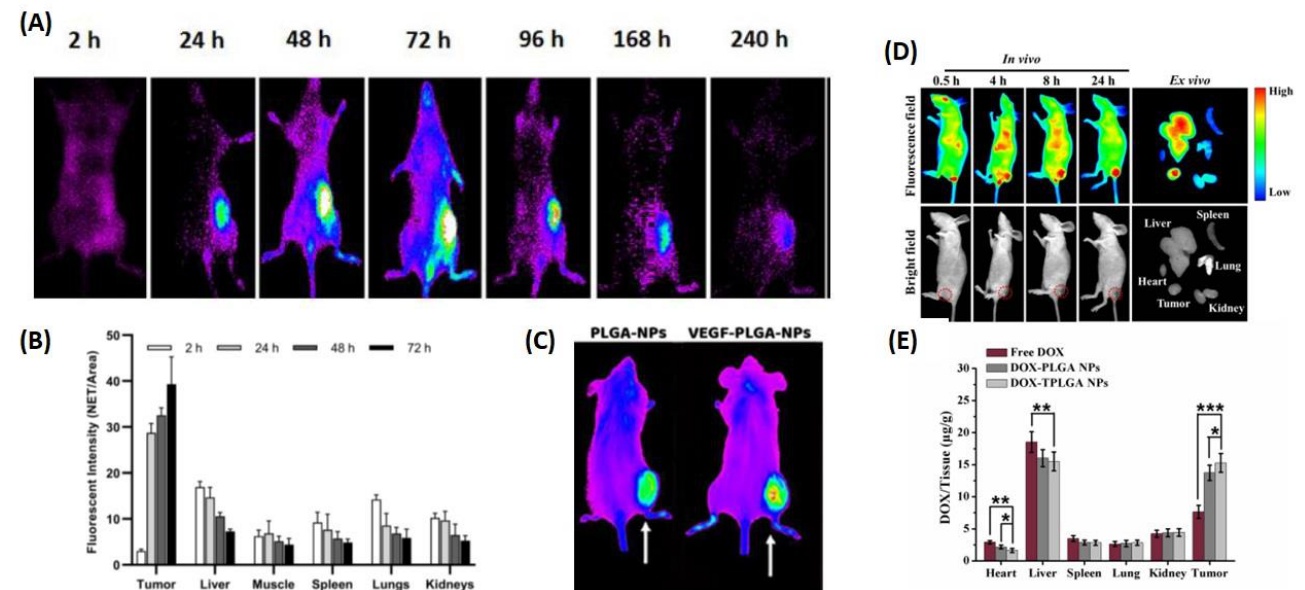
Figure 8. The figure represents different applications of PLGA. ( A ) Optical photographs taken of the entire mouse after 2, 24, 48, 72, 96, 168, and 240 h after subcutaneous injection of 500 µg of fluorescent PLGA-NPs in the right flank in a syngeneic tumor-bearing mouse. ( B ) Analyzing the PLGA-NPs’ biodistribution in BALB/c mice. This data is shown as the mean fluorescence (NET/Area) ±SD from 5 different mice at each time point. ( C ) Images of two syngeneic J744a-carrying mice. 1 tumor located in the right thigh, obtained 24 h post-injection (p.i.) of either native PLGA-NPs (left) or VEGF-PLGA-NPs (right). ( D ) TPLGA NP biodistribution in vivo. 24 h post-injection ex vivo fluorescent pictures of key organs and 4T1 tumors were observed. Red circles indicate tumor locations. Fluorescence intensity decreases from red to blue. ( E ) Tumor and major organ DOX content was determined 24 h after tail-vein injection with free DOX and DOX-loaded NPs. Mean ± SD ( n = 3) was used. * p < 0.05, ** p < 0.01, and *** p < 0.001. Figure ( A – C ) is reproduced from [101] and Figure ( D , E ) are adapted from [96] with copyright permission.